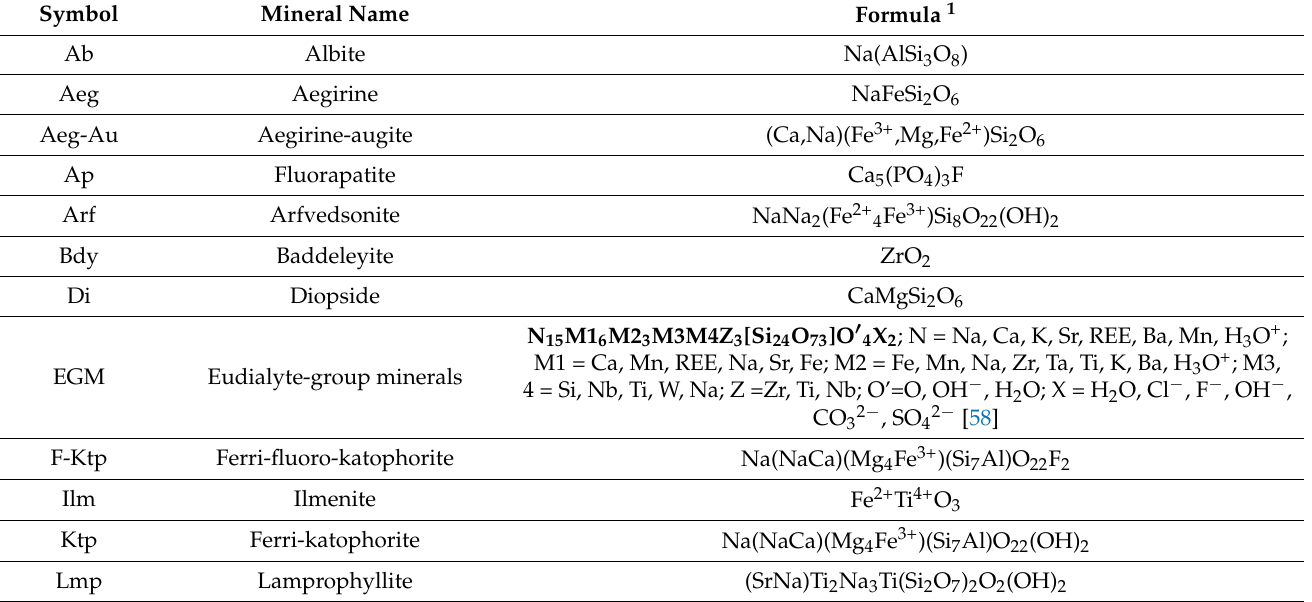
Table 3. Mineral abbreviations used in figures and